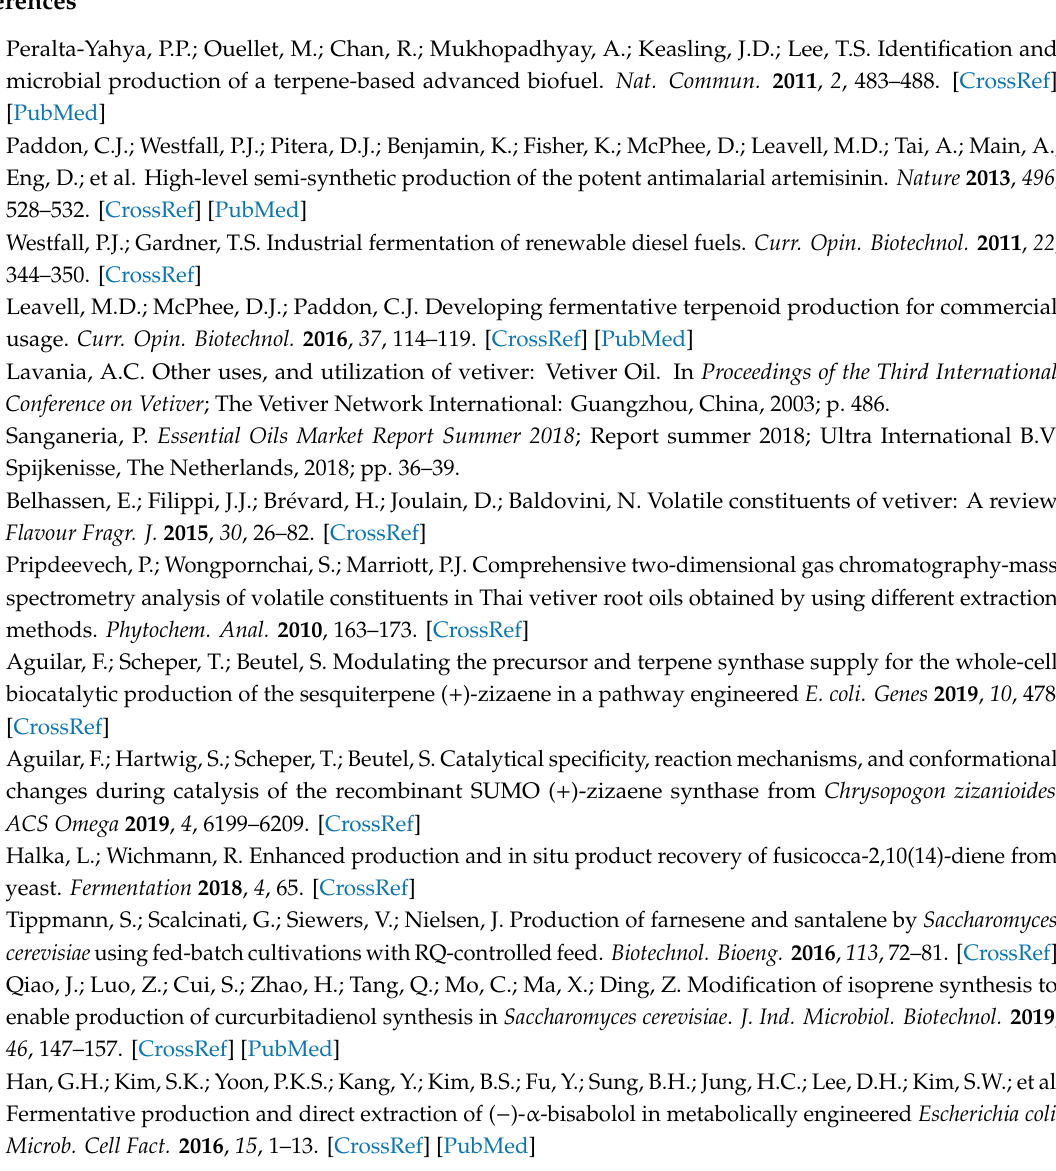
Supplementary Materials: The following are available online: Figure S1: Terpene profile between distinct polymeric adsorbers; Figure S2: Mass spectra of terpene products; Figure S3: Comparison of soluble and insoluble ZS protein amounts between distinct polymeric adsorbers; Figure S4: O ff -line analytics from bioreactor configurations; Table S1: Physicochemical properties of the organic solvents used for the desorption of ( + )-zizaene; Table S2: Recovery ratio of ( + )-zizaene from distinct polymeric